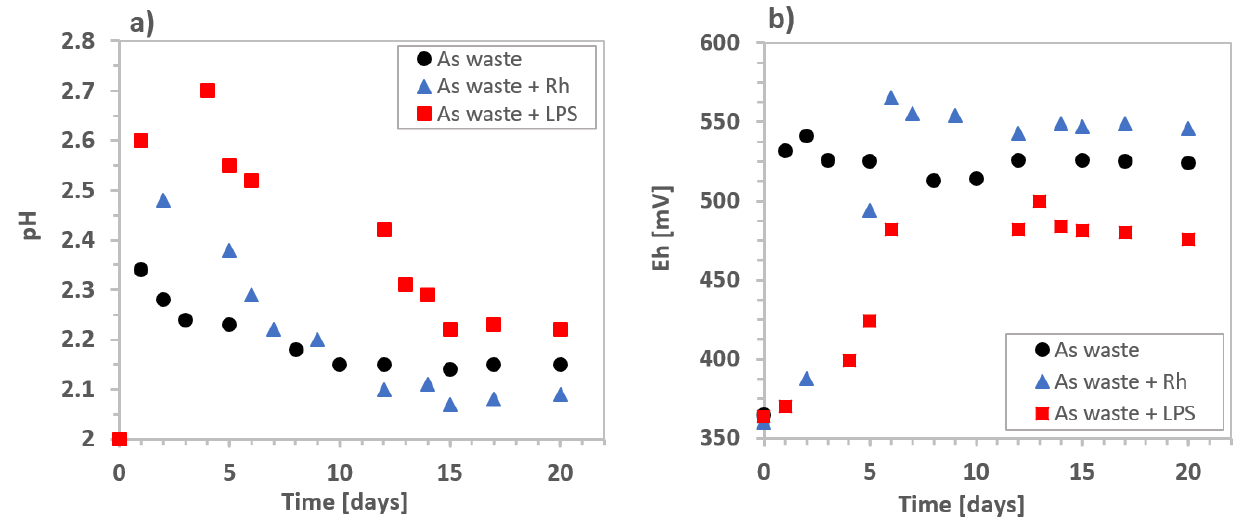
Figure 9. Changes in ( a ) pH and ( b ) redox potential during